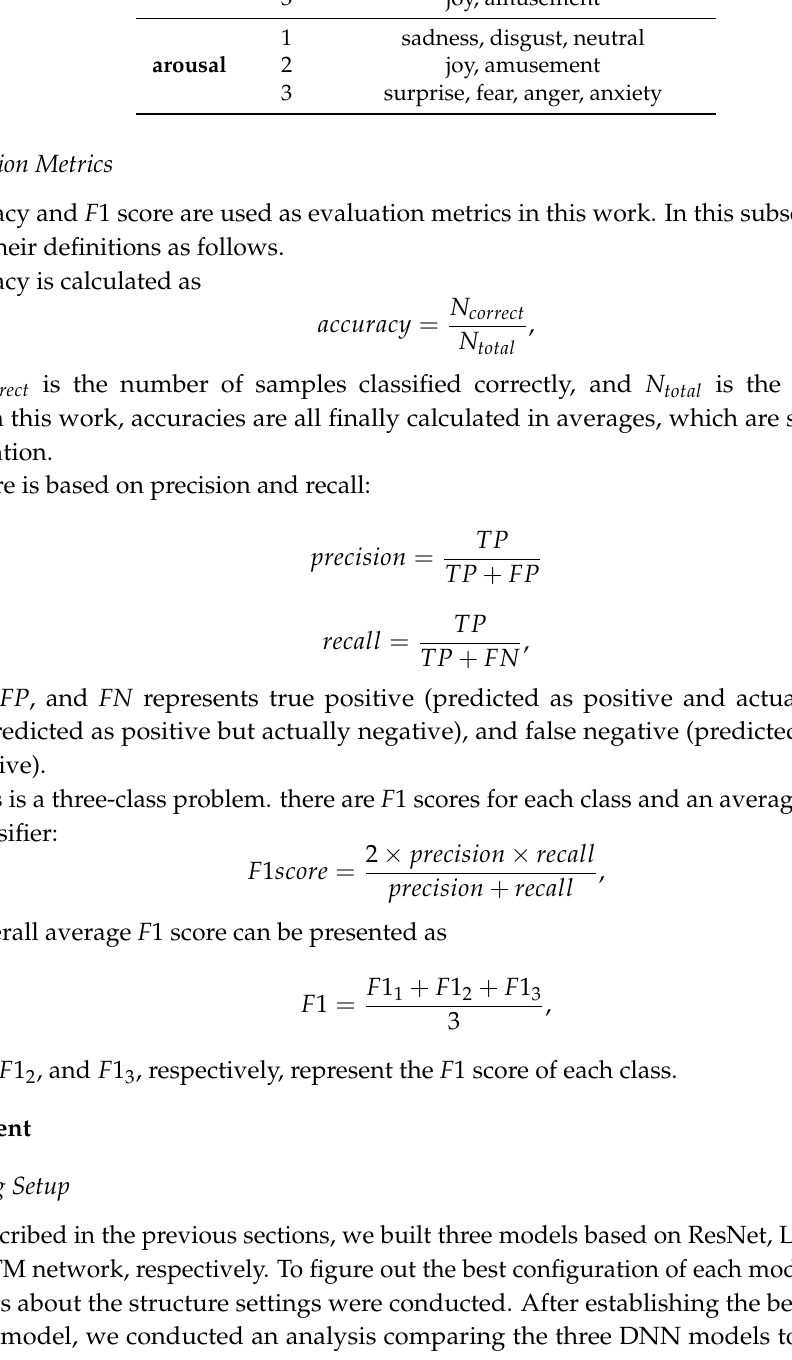
Table 2. Three emotional classes of MAHNOB-HCI on valence and arousal. V/A Label Emotion Keywords 1 fear, anger, anxiety, sadness, disgust valence 2 neutral, surprise 3 joy, amusement 1 sadness, disgust, neutral arousal 2 joy, amusement 3 surprise, fear, anger,